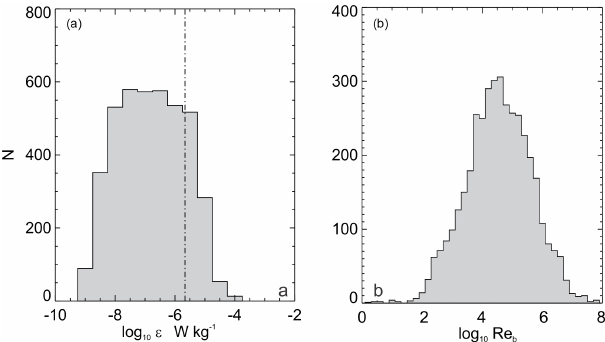
Figure 10. Distributions of (a) dissipation rate ε and (b) buoyancy Reynolds number, Re b